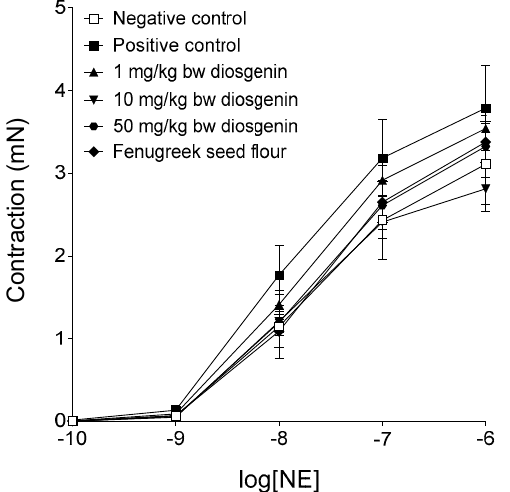
Figure 2. The effect of norepinephrine (NE) on the abdominal aorta isolated from rats treated with dietary fenugreek seed flour or different doses of diosgenin in addition to high-fat, high-sugar diet (HFHSD), and from rats forming the positive (receiving HFHSD only) and negative (getting conventional rat food and tap water) controls. The axis x shows the common logarithm of molar concentration of NE, while the axis y indicates the contractile force of the aortic rings (over the resting level). The length of the rings was the same throughout the study. The symbols represent the effect of NE averaged within the groups (±SEM).